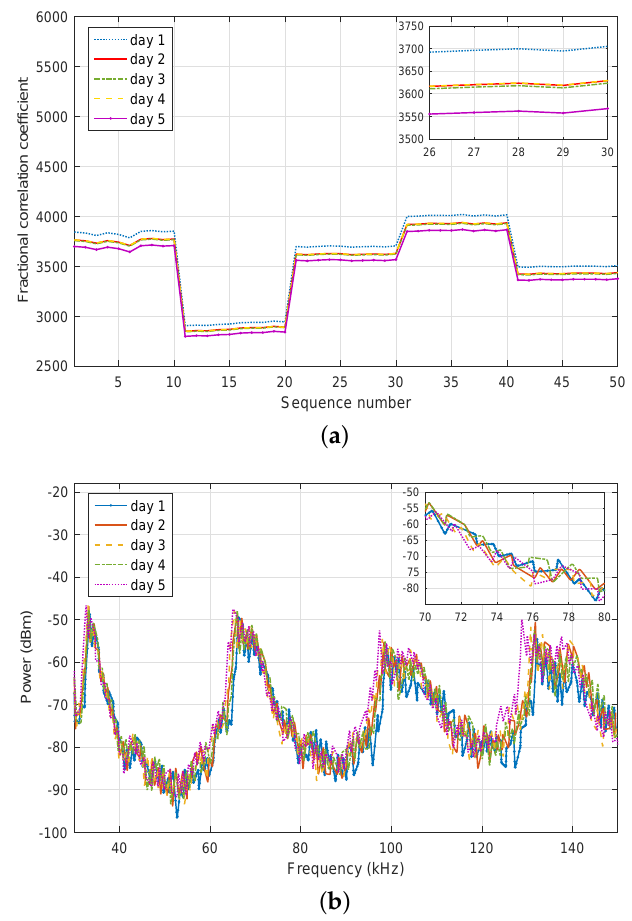
Figure 7. Correlation coefficients and fitted broadband components for the fluorescent table lamp over five consecutive days: ( a ) Fractional correlation coefficient; ( b ) fitted broadband component by B-spline curve